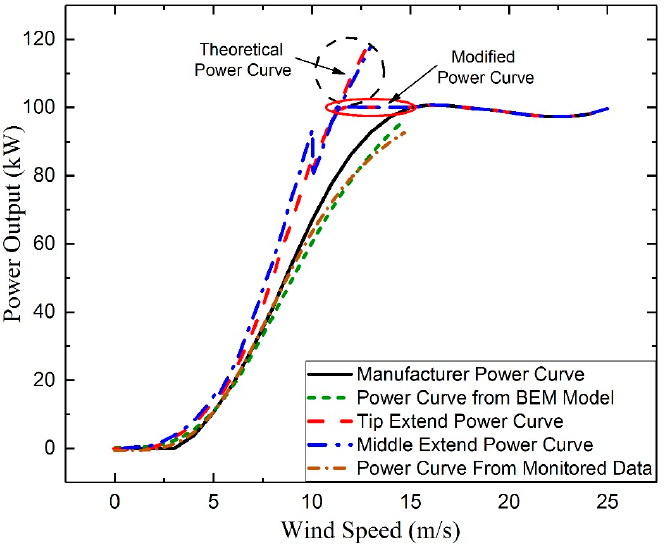
Figure 10. Comparison of the power curves for the original length blade, tip-extended blade and middle-extended blade. middle-extended